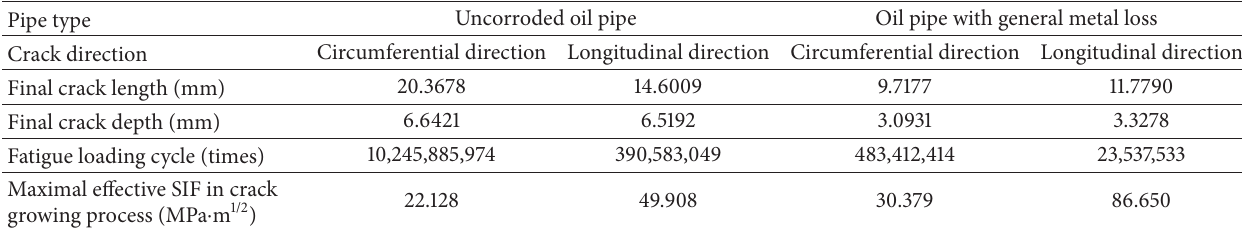
Table 2: Crack growth property on the oil pipe with different corrosion